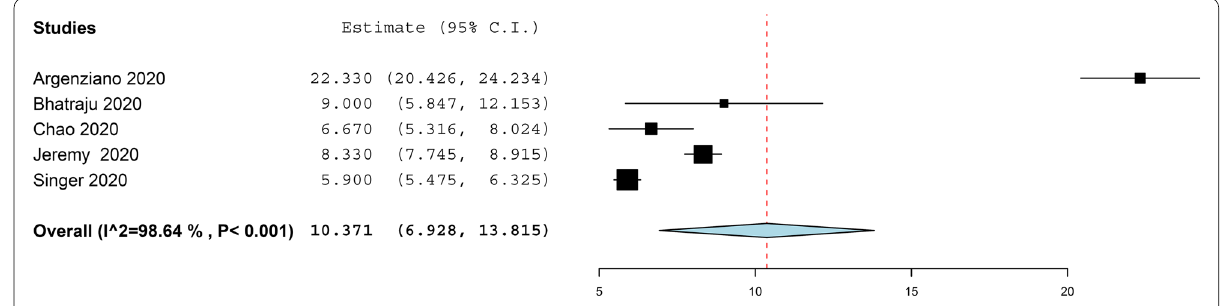
Fig. 6 The intensive care unit time in COVID‑19